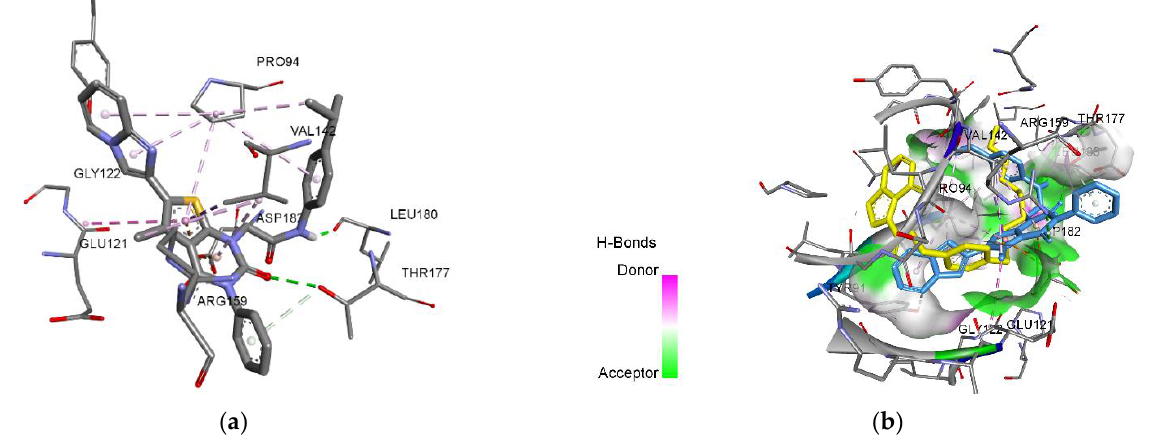
Figure 3. 3-D visualization: ( а ) interaction of the ligand 4.2 with amino acids of the active site of TrmD; ( b ) conformational pose of the reference inhibitor (yellow molecule) [19] and the ligand 4.2 (blue molecule) in the active site of P. aeruginosa TrmD. Table 2. The results of the docking studies of 3, 4.1 and 4.2 and the native inhibitor to the active site of P. aeruginosa TrmD.